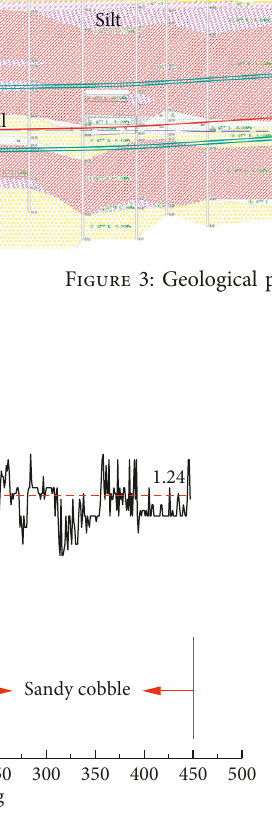
Figure 4: History of rotational speed of cutterhead.